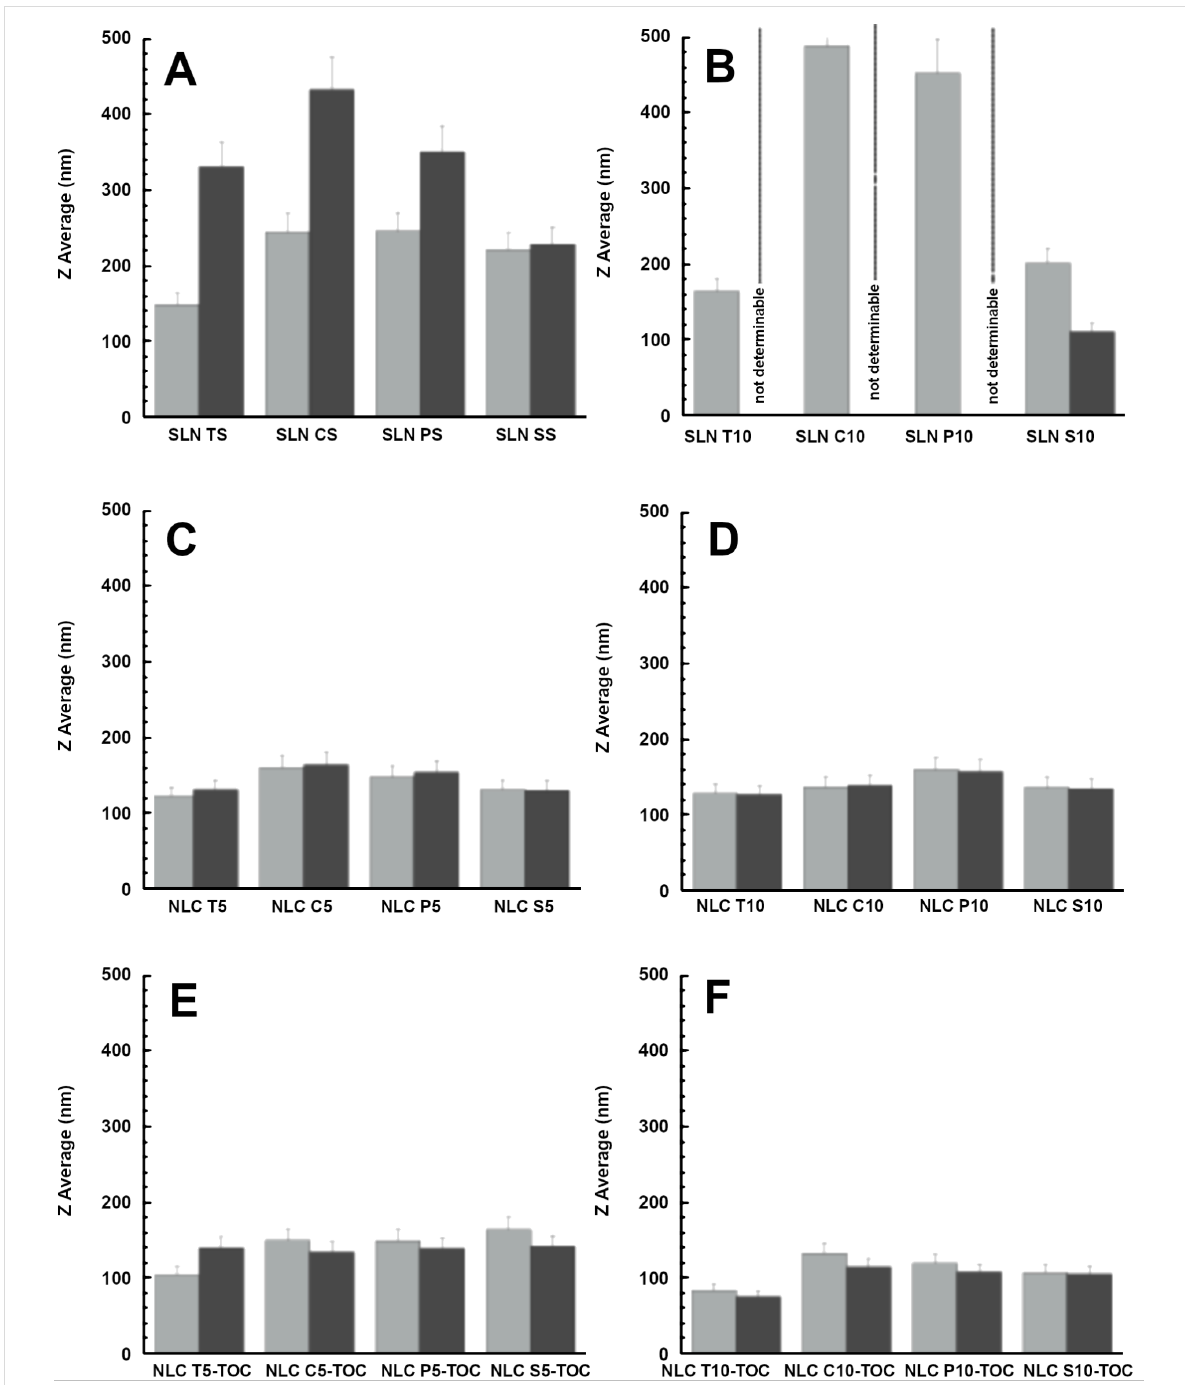
Figure 1: Variation of the Z-average mean diameters, D z , of SLNs (A, B) and NLCs (C, D) produced in the absence of antioxidants and NLC loaded with TOC (E, F) evaluated at 1 (light grey) and 90 (grey) days after nanoparticle production. In the case of SLN T10, SLN C10 and SLN P10, mean di- ameters were not measurable by PCS 90 days after